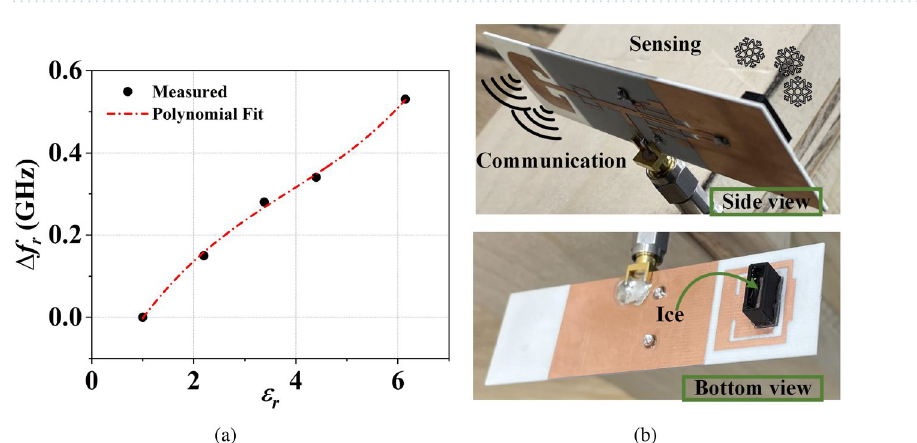
Figure 11. ( a ) Substrate block on top of the antenna sensor. ( b ) Simulated and measured Input reflection coefficients of the proposed system in presence of different substrate blocks on the antenna sensor.